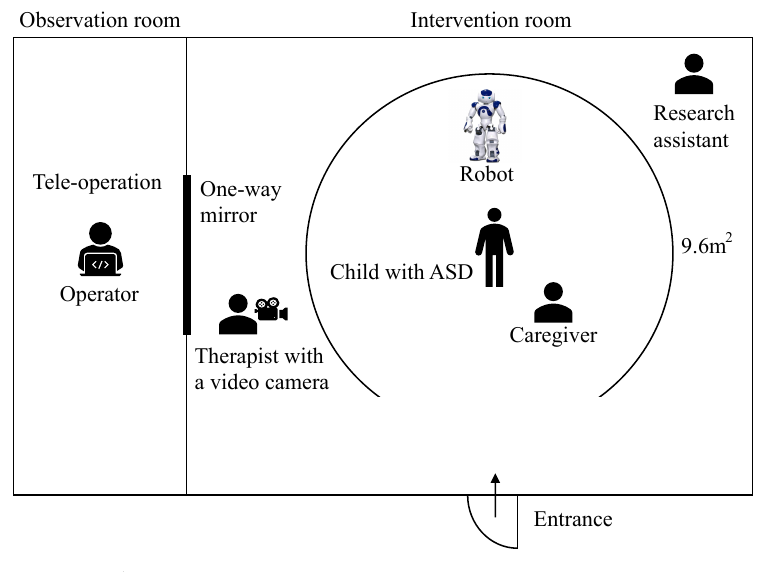
Figure 1. Therapy room